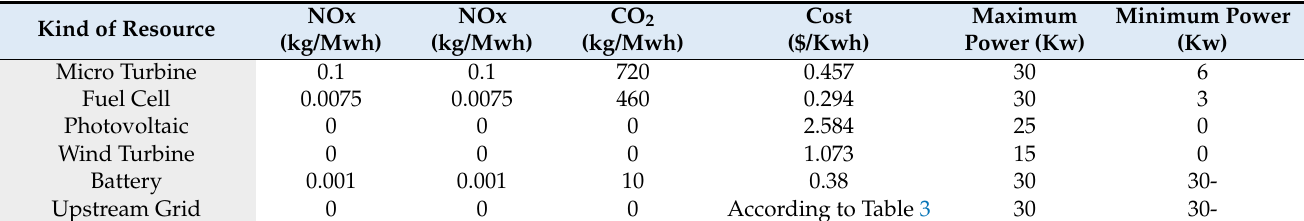
Table 1. The figures for gas emissions of resources, costs, and minimum and maximum production. Kind of Resource Micro Turbine Fuel Cell Photovoltaic Wind Turbine 0 0 Battery Upstream